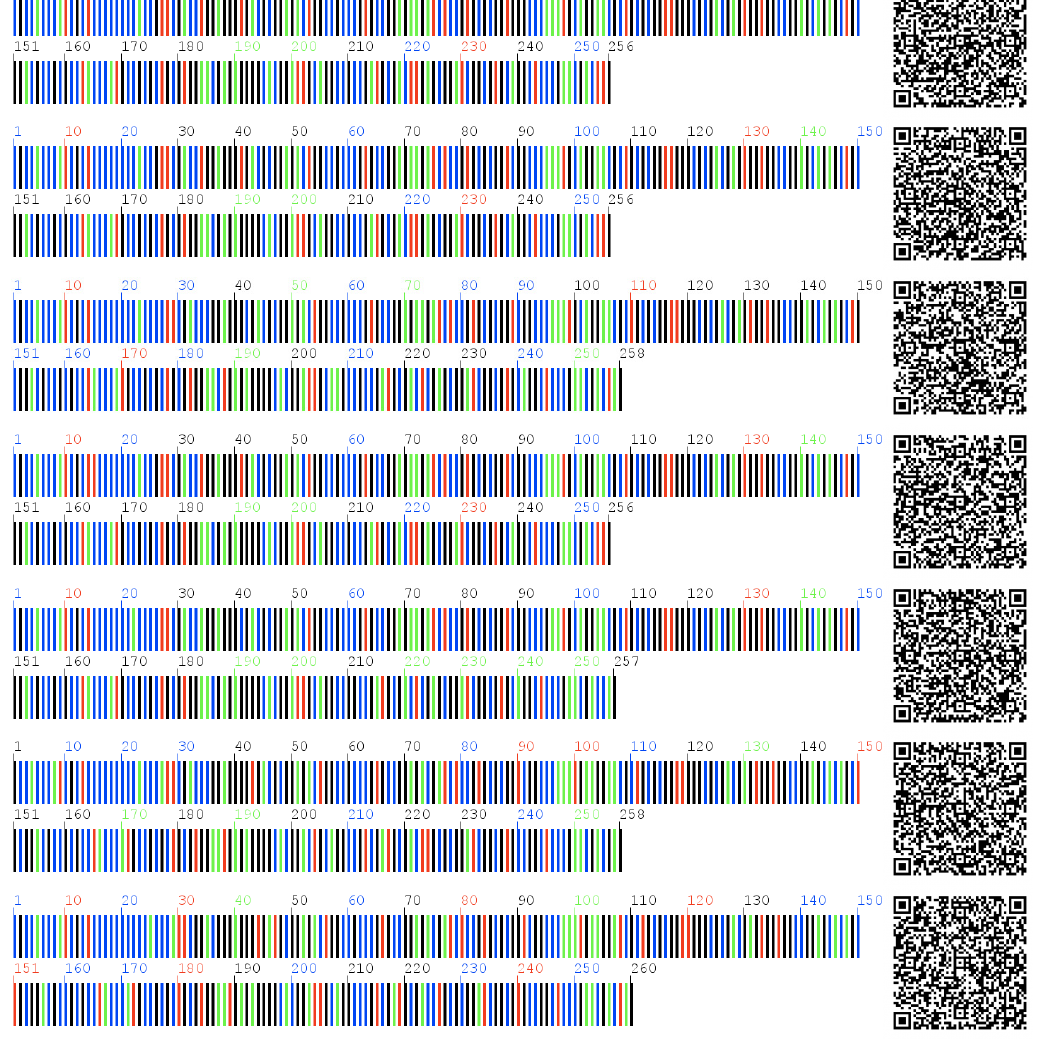
Figure 3. ITS2 sequences barcode and two ‐ dimensional DNA barcode image of Shi ‐ Liang tea and its closely related species ( ■ A ■ T ■ C ■ G). The image list in the order of C. salicifolius , C. zhejiangensis , C. praecox , C. nitens , C. campanulatus , Calycanthus floridus, and Ca. chinensis